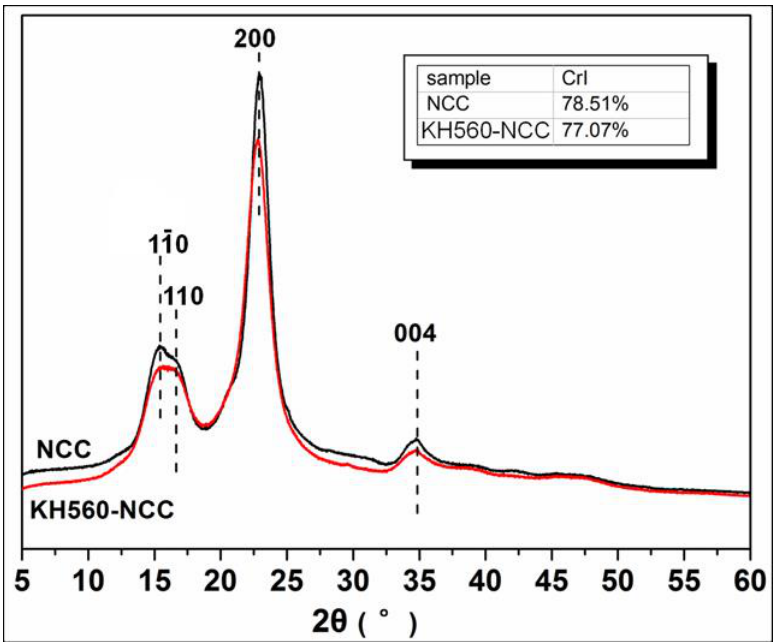
Figure 4. XRD patterns of NCC and KH560-NCC.